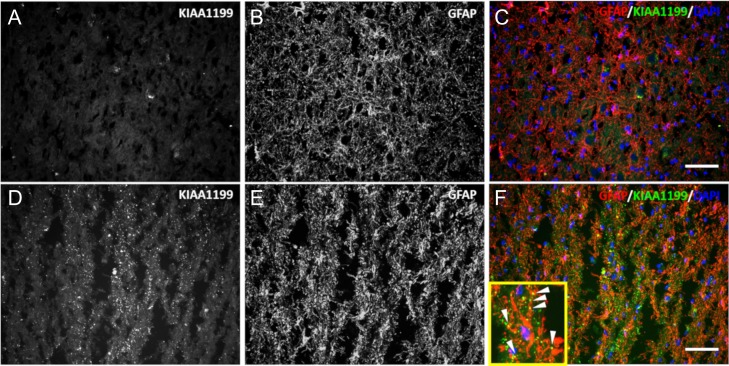
Activated astrocytes express KIAA1199 protein in the pons of an individual with multiple sclerosis (MS). Tissue sections from a control patient (A–C) or an MS patient (D–F), were costained for KIAA1199 (A, D) and GFAP (B, E). Merged panels (C) and (F) display KIAA1199 (green), GFAP (red) and the nuclei DAPI counterstain (blue). KIAA1199 expression was colocalized with GFAP-positive cells in MS samples (scale bar, 50 μm). Inset in panel (F) shows a high magnification of the composite image. Presence of the KIAA1199 protein within the astrocytes process is indicated by closed arrows.